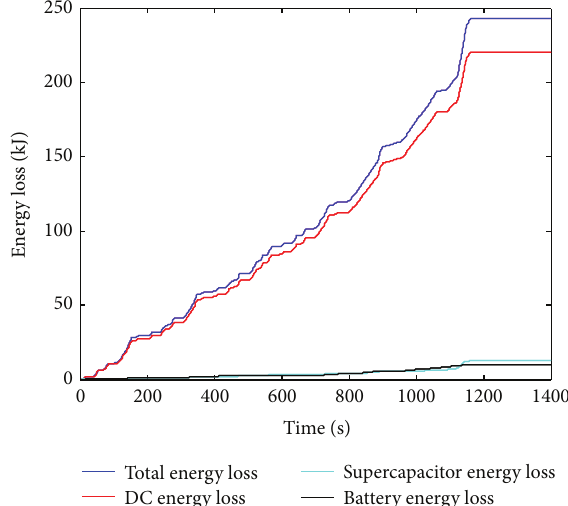
Figure 37: Energy loss of the semiactive topological structure described in Figure 3 for NEDC driving cycle. Table 4: Parameters of battery life